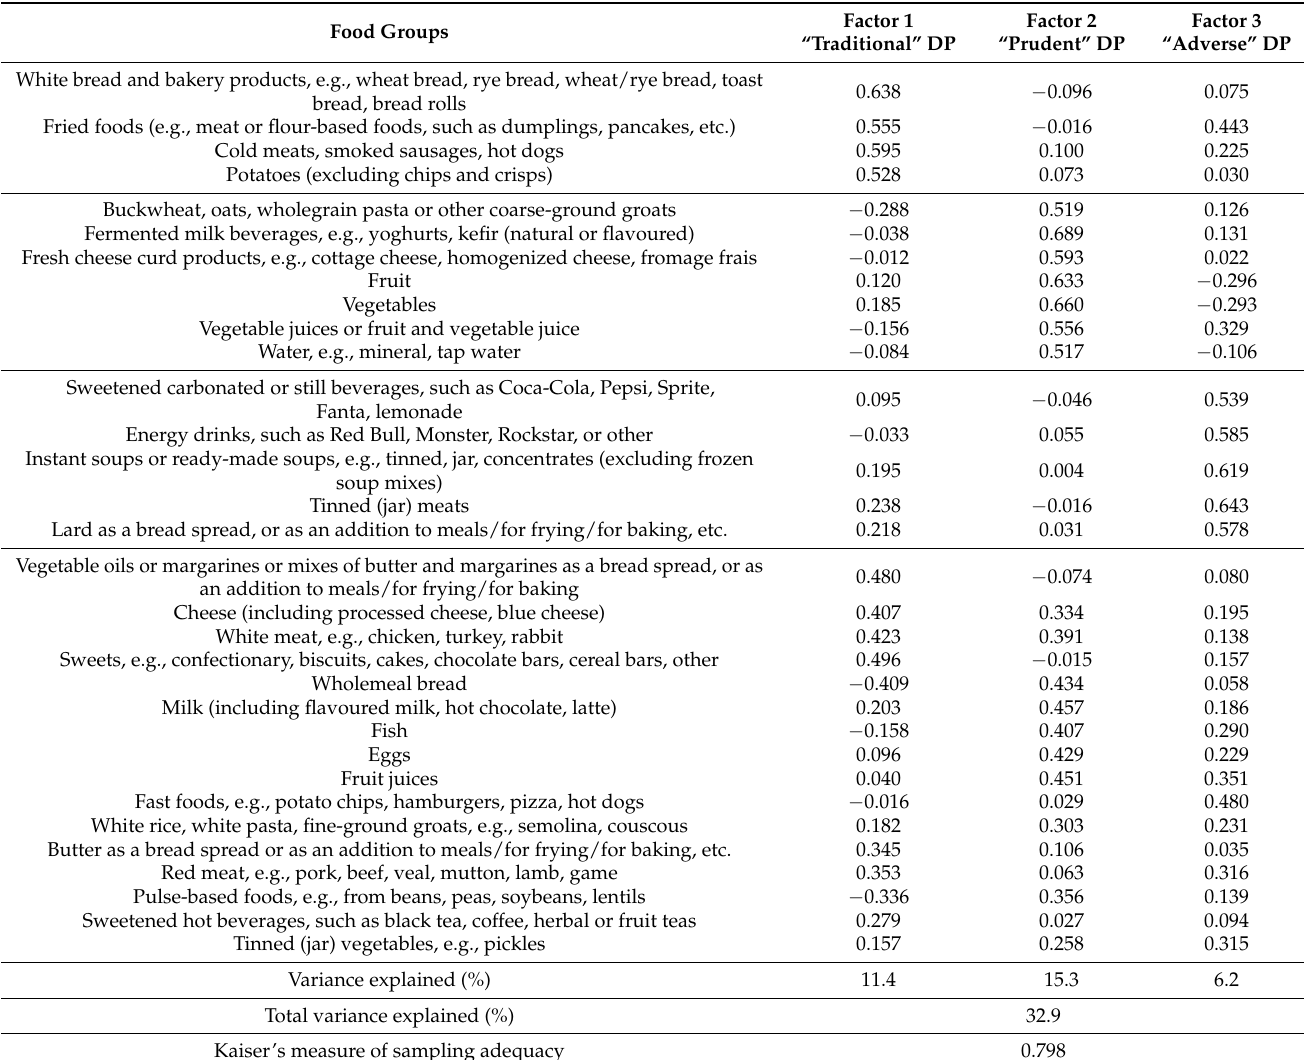
Table 2. Factor-loading matrix for the dietary patterns identified using Varimax